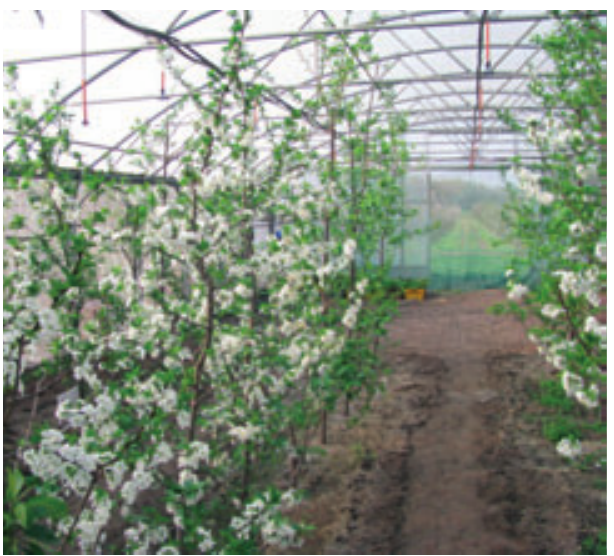
Photo 1. Cherry trees in full bloom.